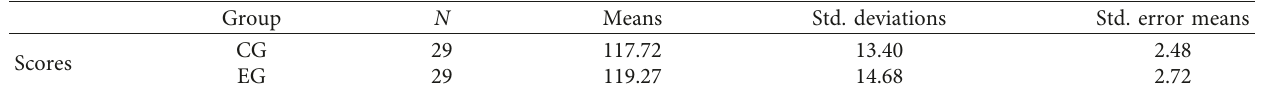
Table 5: Descriptive statistics (motivation pretest of both groups).